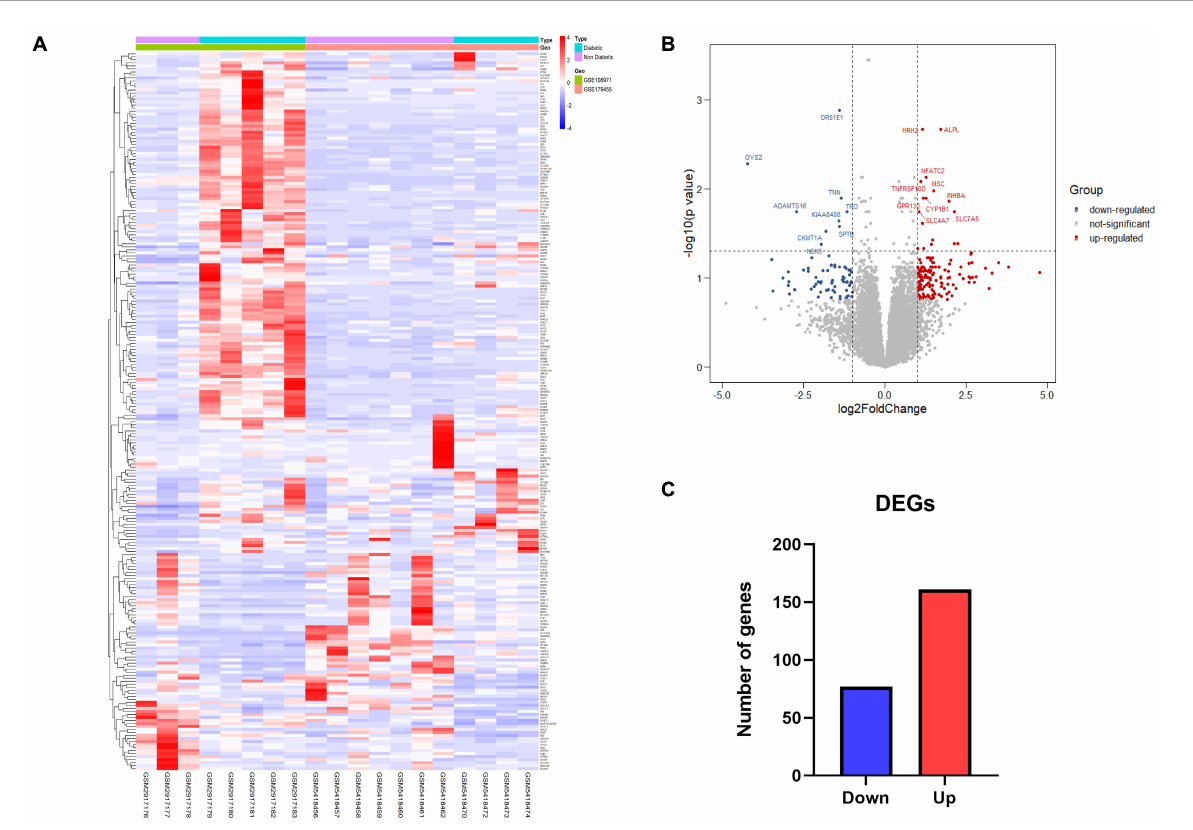
FIGURE2 Identification of all differentially expressed genes (DEGs) between diabetic and non-diabetic EAT. (A) The heatmap of DEGs. Red represents upregulated genes; blue represents downregulated genes. (B) The volcano plot of 238 DEGs. Upregulated genes were in red dots; downregulated genes were in blue dots. P -value < 0.01 and | log 2 FC| > 1. (C) Numbers of DEGs. 161 genes were upregulated; 77 genes were downregulated. DEGs, differentially expressed genes; EAT, epicardial adipose